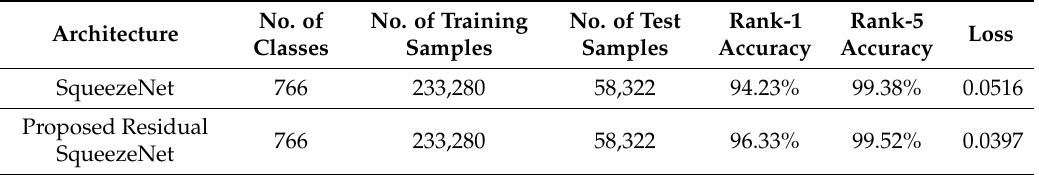
Table 2. Performance of SqueezeNet and residual SqueezeNet.